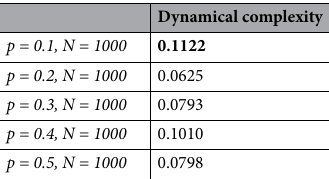
Table 1. Dynamical complexity of the topologies, p ≡ β 0 . Significant values are in